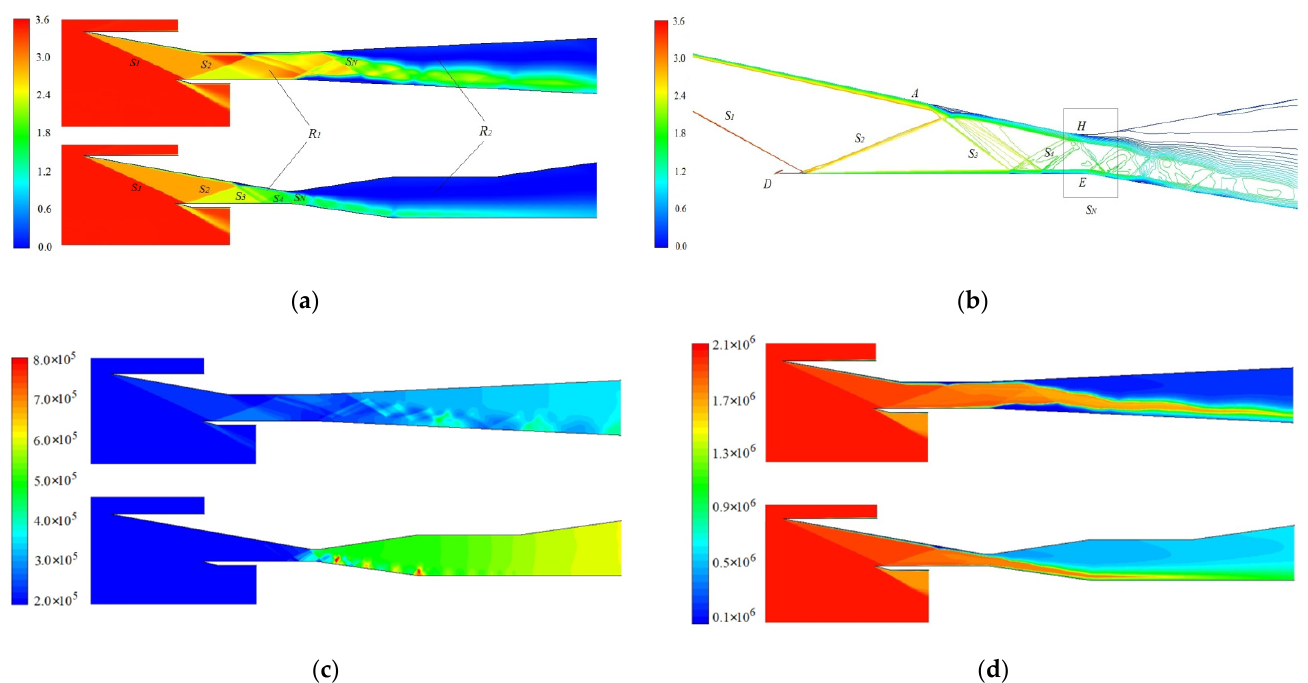
Figure 8. Comparison of the contours of Ma ∞ 3.5. ( a ) Mach number; ( b ) shock wave system; ( c ) static pressure; ( d ) total pressure.